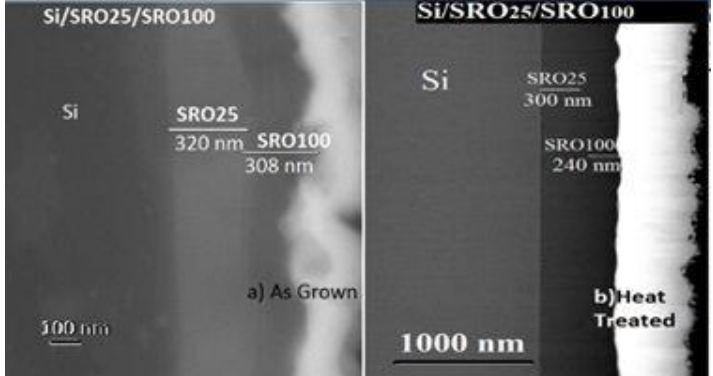
/ SRO 25 / 100 structure as grown and with